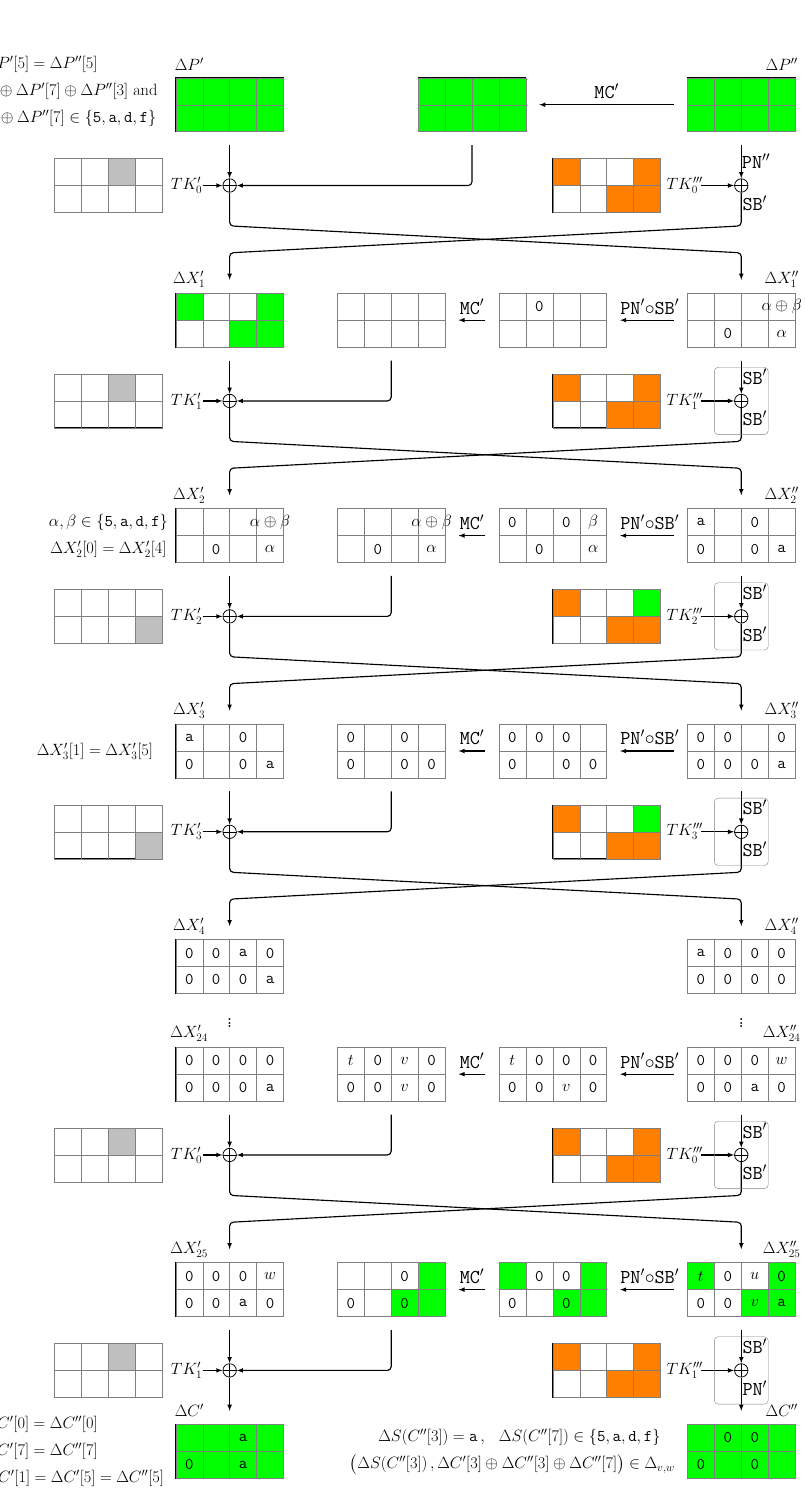
Figure 5: Extending the 21-round activity pattern RT 0 from Table 5 by four rounds before and one round after the